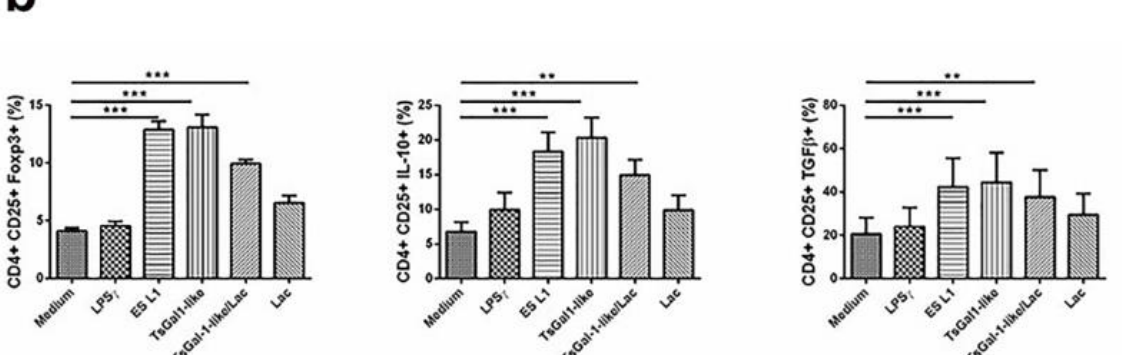
Figure 6: Tolerogenic properties and functions of TsGal-1-like proteins-treated DCs . DCs treated with ES L1 antigens (50 μg/ml), TsGal-1-like proteins (5 μg/ml) and LPS/IFN  were washed thoroughly and then cocultured with magnetic-activated cell sorting-purified allogenic T cells (Tly) (1 × 10 5 /well) for 3 days in 1:50 DC:T cell ratio and then re-stimulated with interleukin (IL)-2 (2 ng/ml) for another 3 days. ( a ) Representative analysis of CD25 + Foxp3 + cells within CD4 + T cells and IL-10 and transforming growth factor (TGF)-β within CD4 + CD25 + T cell population is shown, ( b ) the summarized results for the expres- sion of CD4 + CD25 + FoxP3 + T regulatory cells and IL-10 and TGF-β within CD4 + CD25 + T cells are shown as the mean % ± SD from three different experiments. *p < 0.05, **p < 0.01, ***p < 0.005 compared as indicated by line (one-way ANOVA with Tukey’s